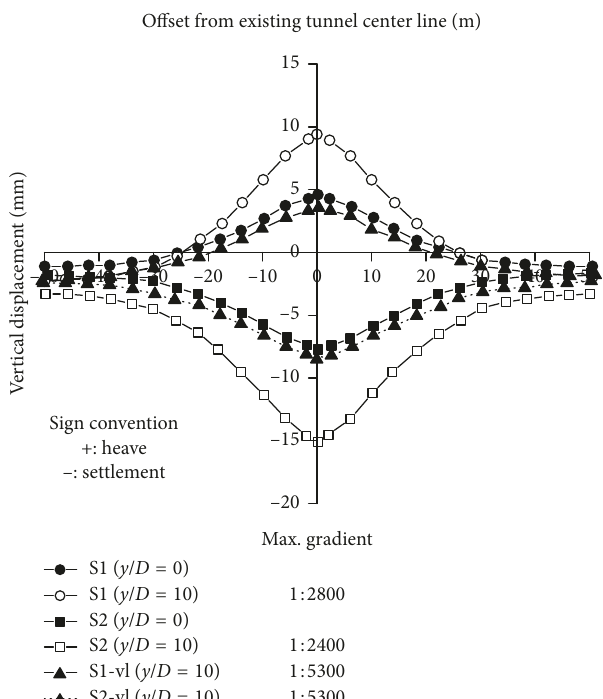
Figure 8: Comparison of longitudinal tunnel vertical tunnel along section B-B (Figure 1) for different advancing stages expressed in terms of y / D ratios. Each y / D ratio represents the normalised advanced distance of the tunnel face with the diameter of the tunnel. For instance, at y / D � − 10, the tunnel face is at a distance of 10 D behind the existing tunnel centre line (i.e., monitoring section B-B).